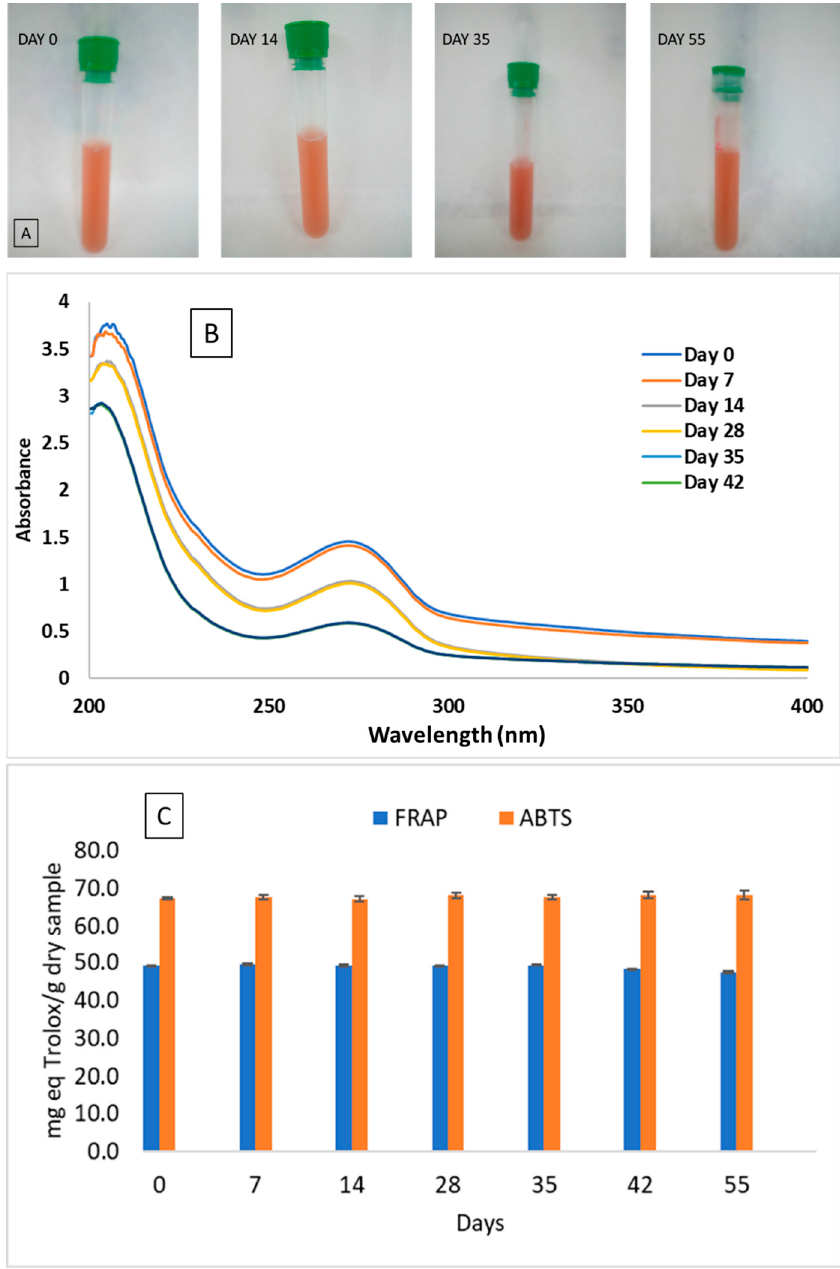
Figure 6. Visual appearance ( A ), UV-Vis spectra ( B ) and antioxidant activity ( C ) of SeNPs after 0, 14, 35 and 55 days stored at 4 °C.